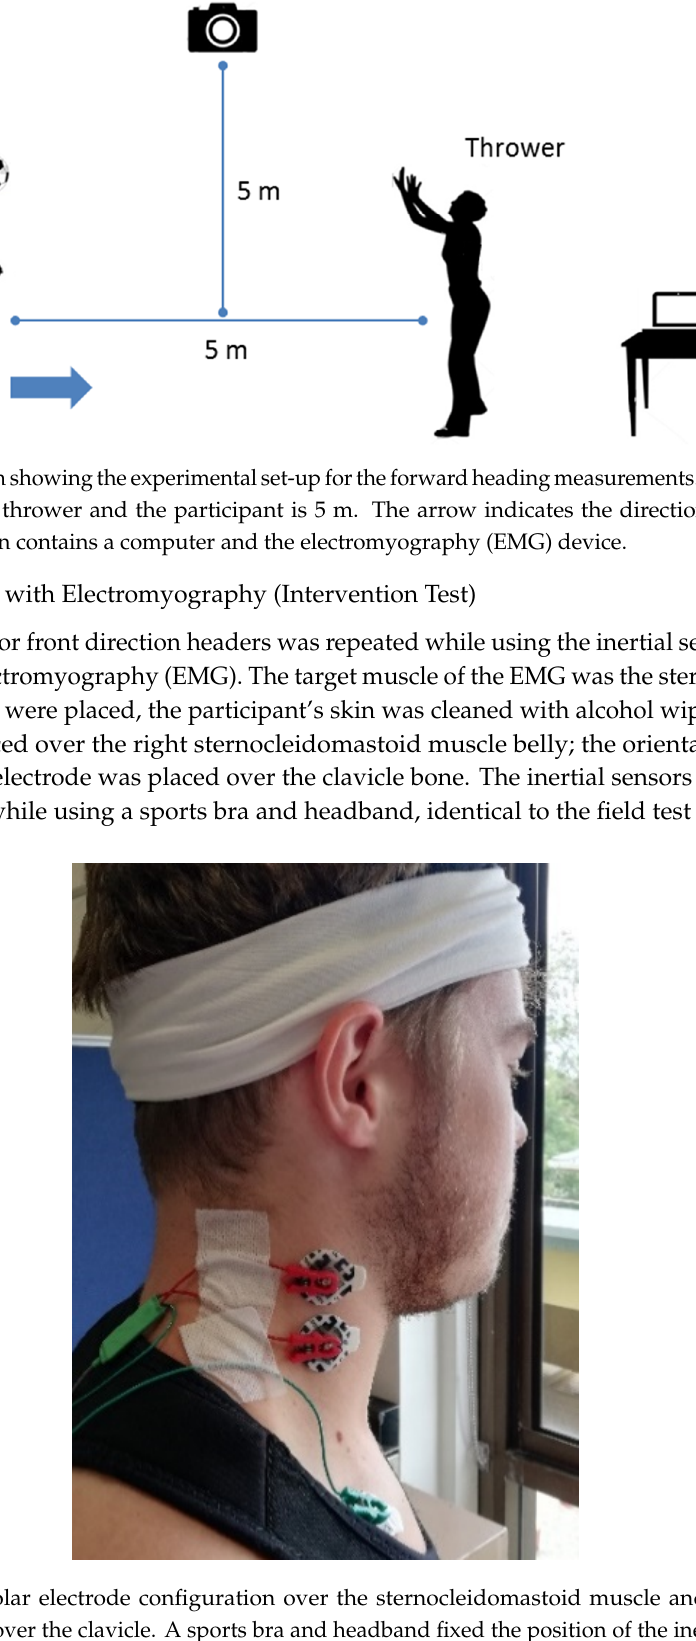
Figure 3. A bipolar electrode configuration over the sternocleidomastoid muscle and a reference electrode placed over the clavicle. A sports bra and headband fixed the position of the inertial